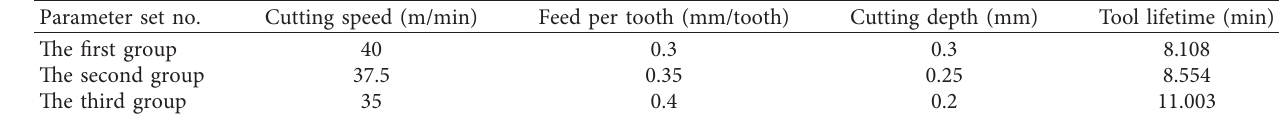
Table 2: Tool lifetime for cutting